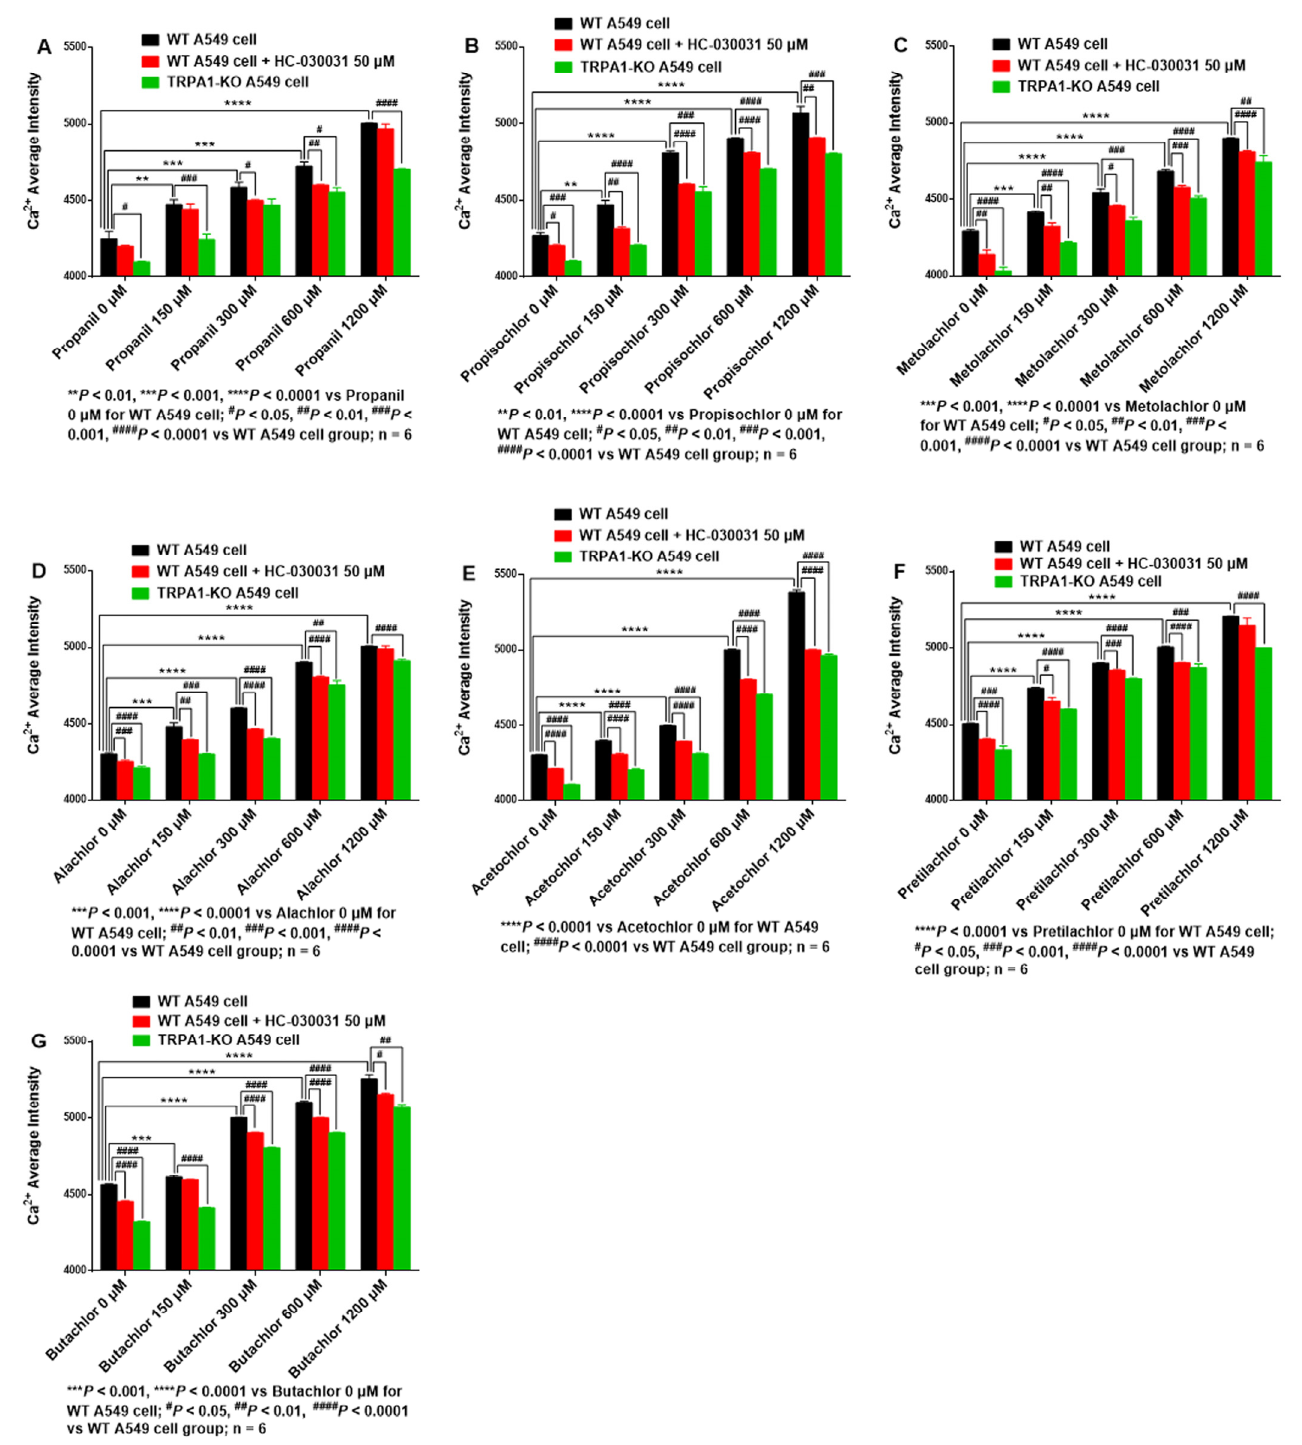
Figure 3. HC-030031 intervention or TRPA1 -KO decreases calcium influx in A549 cells treated with AHs. ( A ) Propanil, ( B ) Propisochlor, ( C ) Metolachlor, ( D ) Alachlor, ( E ) Acetochlor, ( F ) Pretilachlor, ( G ) Butachlor. ment with HC-030031 (50 μ M) significantly decreased calcium influx in A549 cells treated 0.01; 300 μ M, p < 0.0001; 600 μ M, p < 0.0001; 1200 μ M, p < 0.01) (Figure 3B), metolachlor (150 μ M, p < 0.01; 300 μ M, p < 0.05; 600 μ M, p < 0.001; 1200 μ M, p < 0.0001) (Figure 3C),